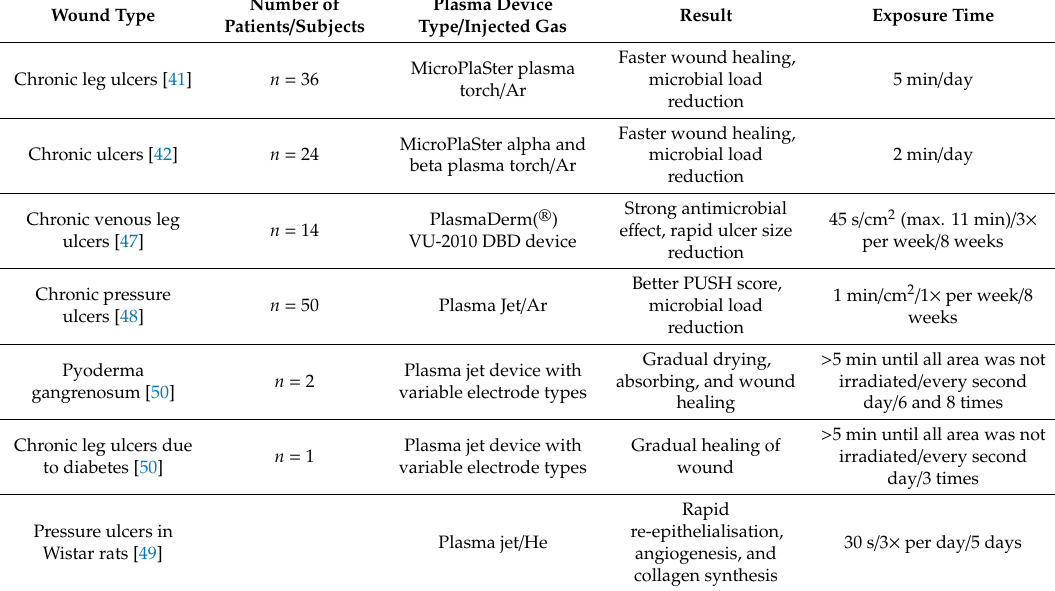
Table 1. List of cold atmospheric plasma (CAP) applications for chronic wound